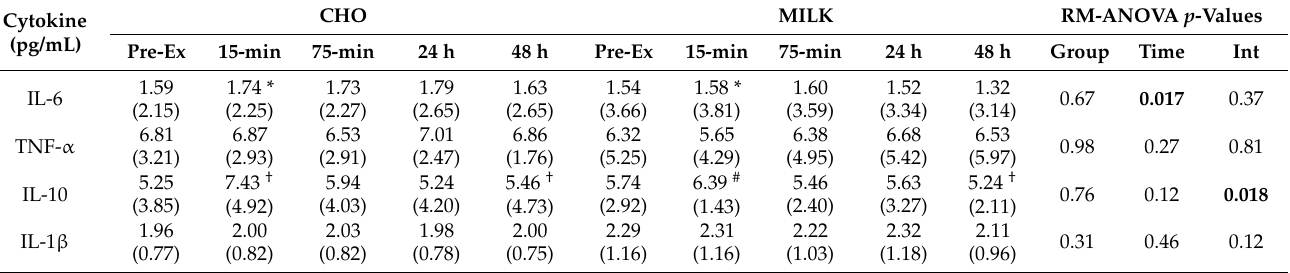
Table 2. Absolute serum concentration of cytokines at pre-exercise, 15-min, 75-min, 24 h, and 48 h post-exercise in the carbohydrate (CHO) and milk (MILK)